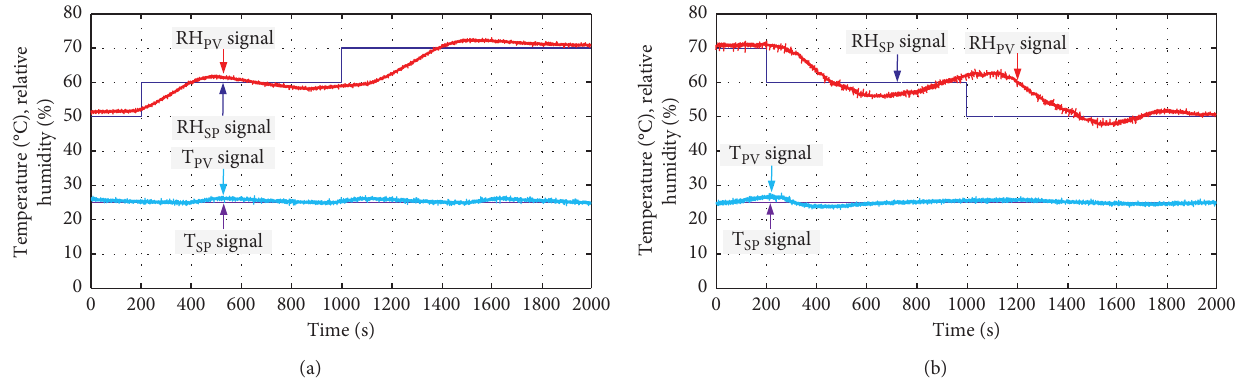
Figure 15: Process response of RH at temperature constant. (a) Upward RH setpoint (%). (b) Downward RH setpoint